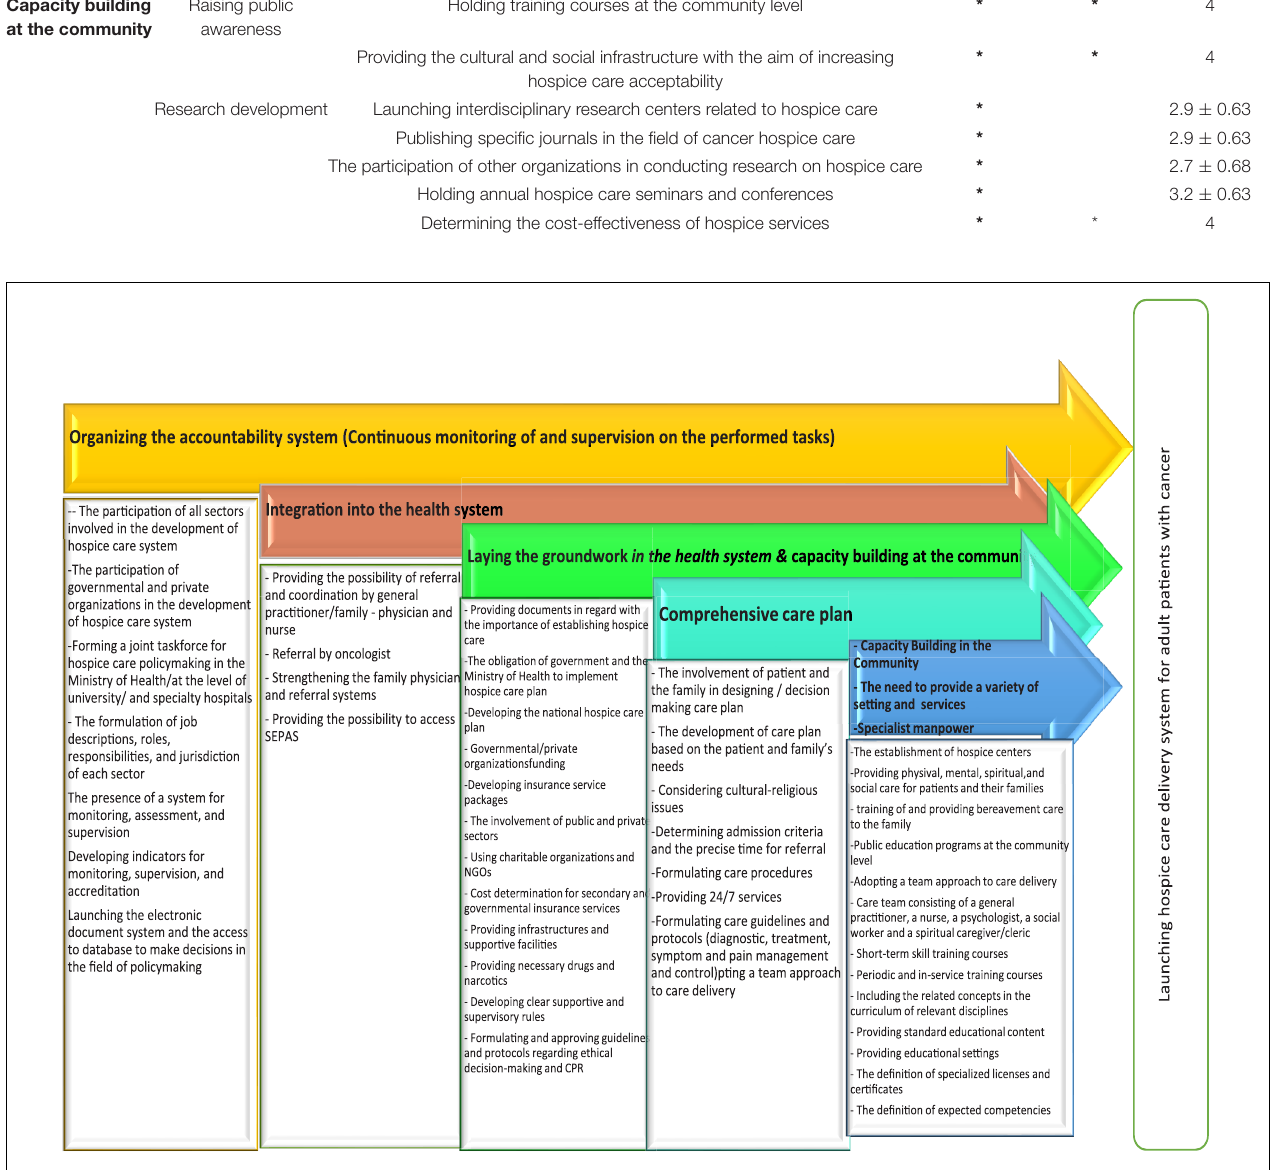
Frontiers in Psychology |